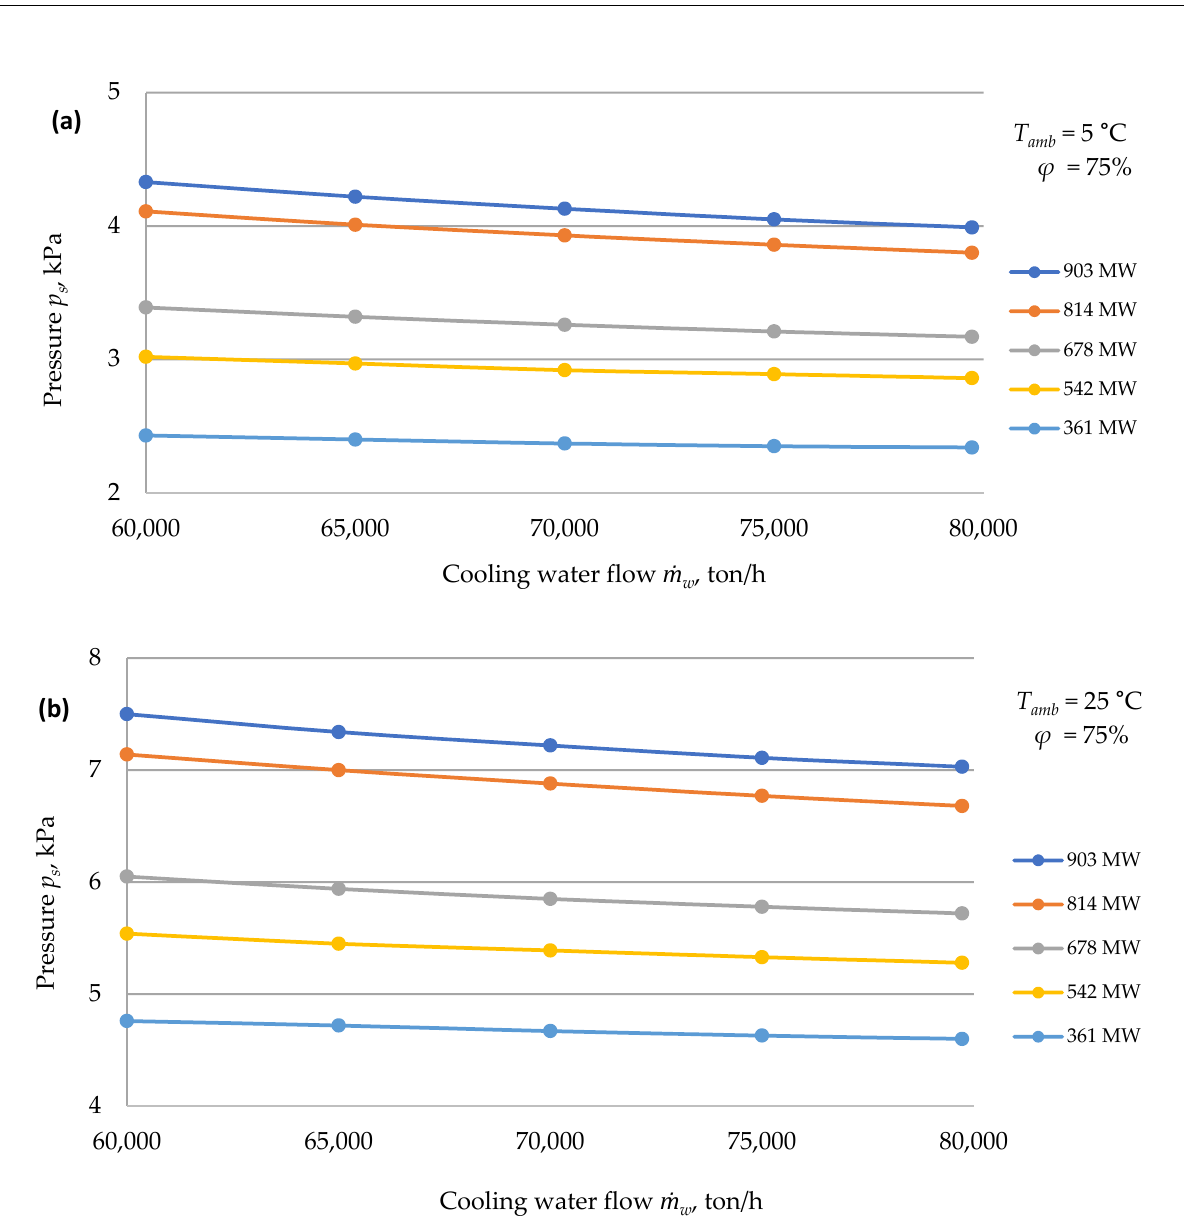
Figure 11. Effect of water flux on steam pressure in turbine condenser for air temperature: ( a ). T amb = 5 °C, ( b ) T amb = 25 °C.